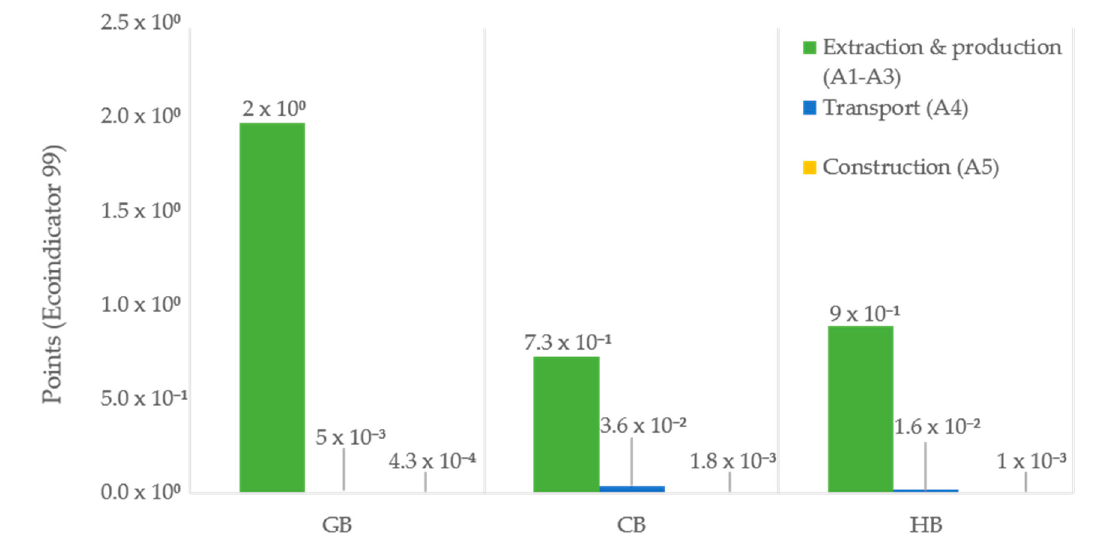
Figure 2. Resume of Eco-indicators by LC